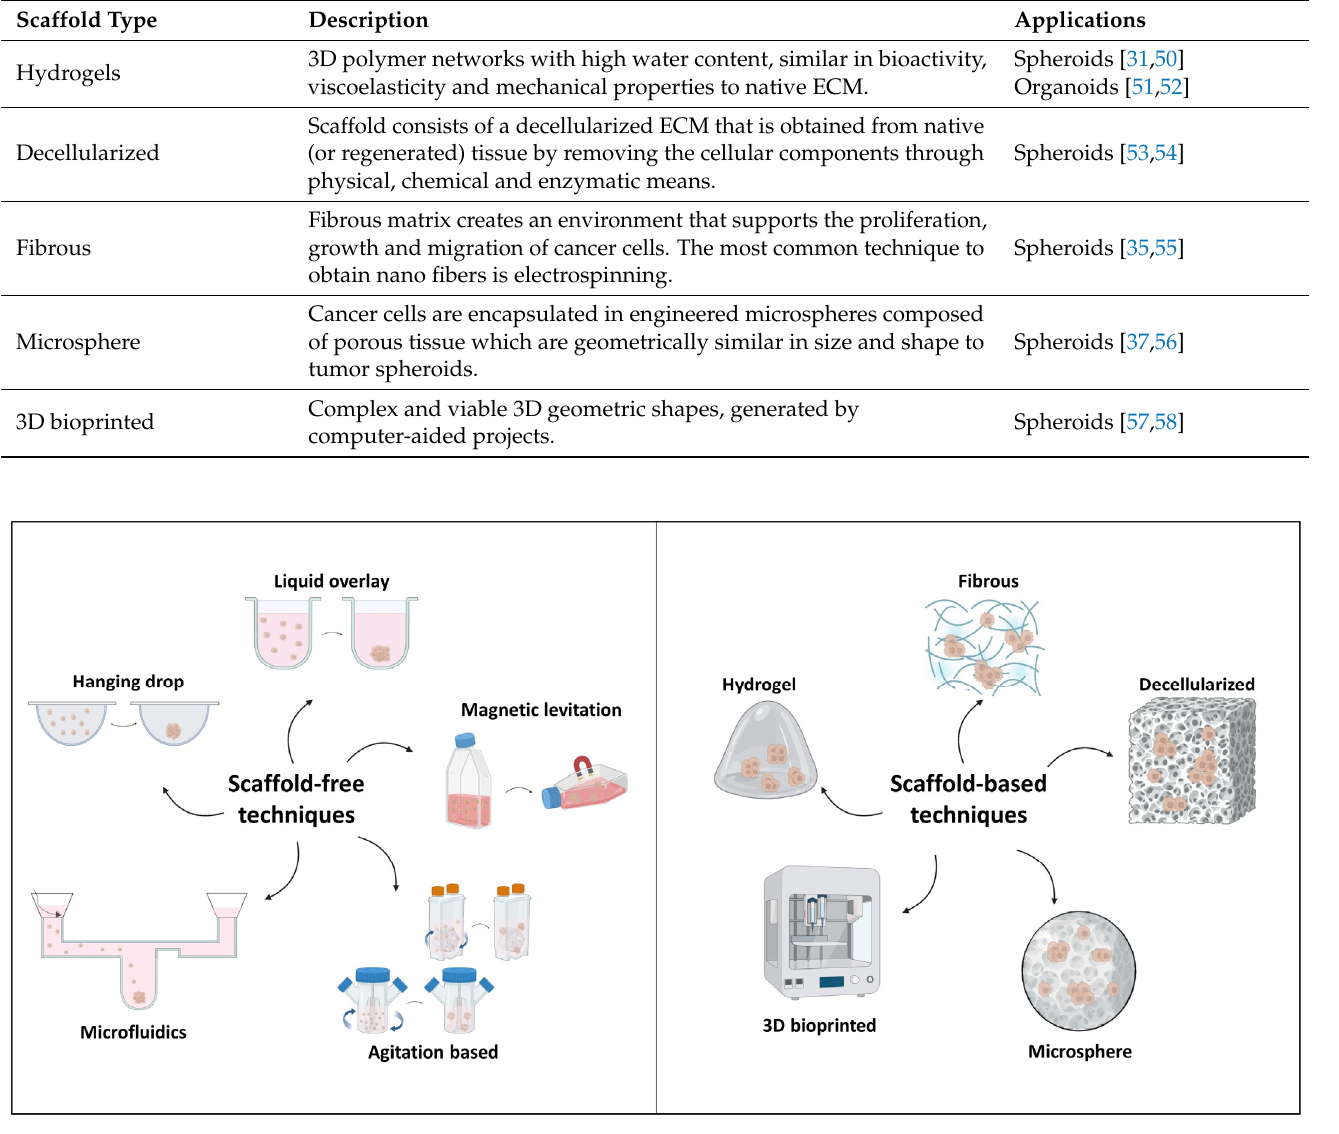
Figure 1. Sca ff old-free and sca ff old-based techniques for 3D in vitro cancer model